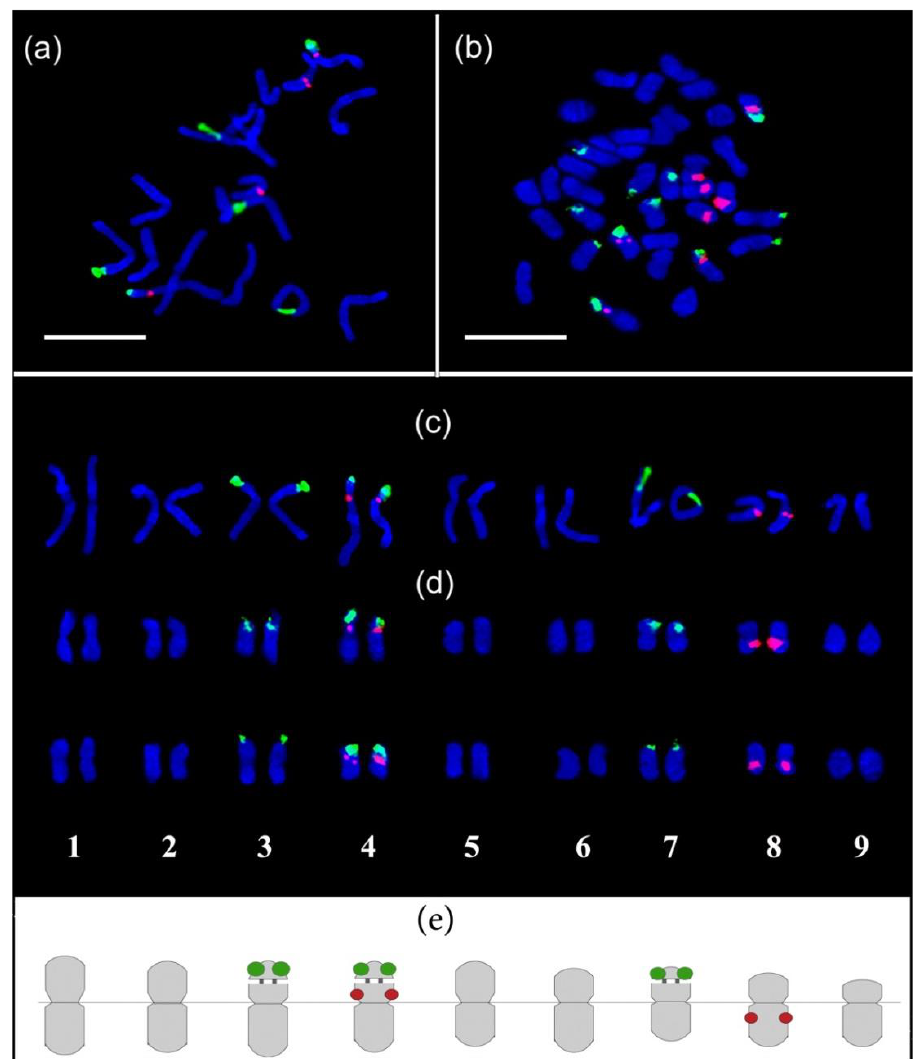
Figure 6. Chromosome spreads and karyograms of the studied diploid ( a , c ) and tetraploid ( b , d ) plants of Polemonium caeruleum after FISH with 45S rDNA (green) and 5S rDNA (red). Idiograms of diploid P. caeruleum chromosomes showing 45S (green) and 5S (red) rDNA sites ( e ). Scale bar—5 µ